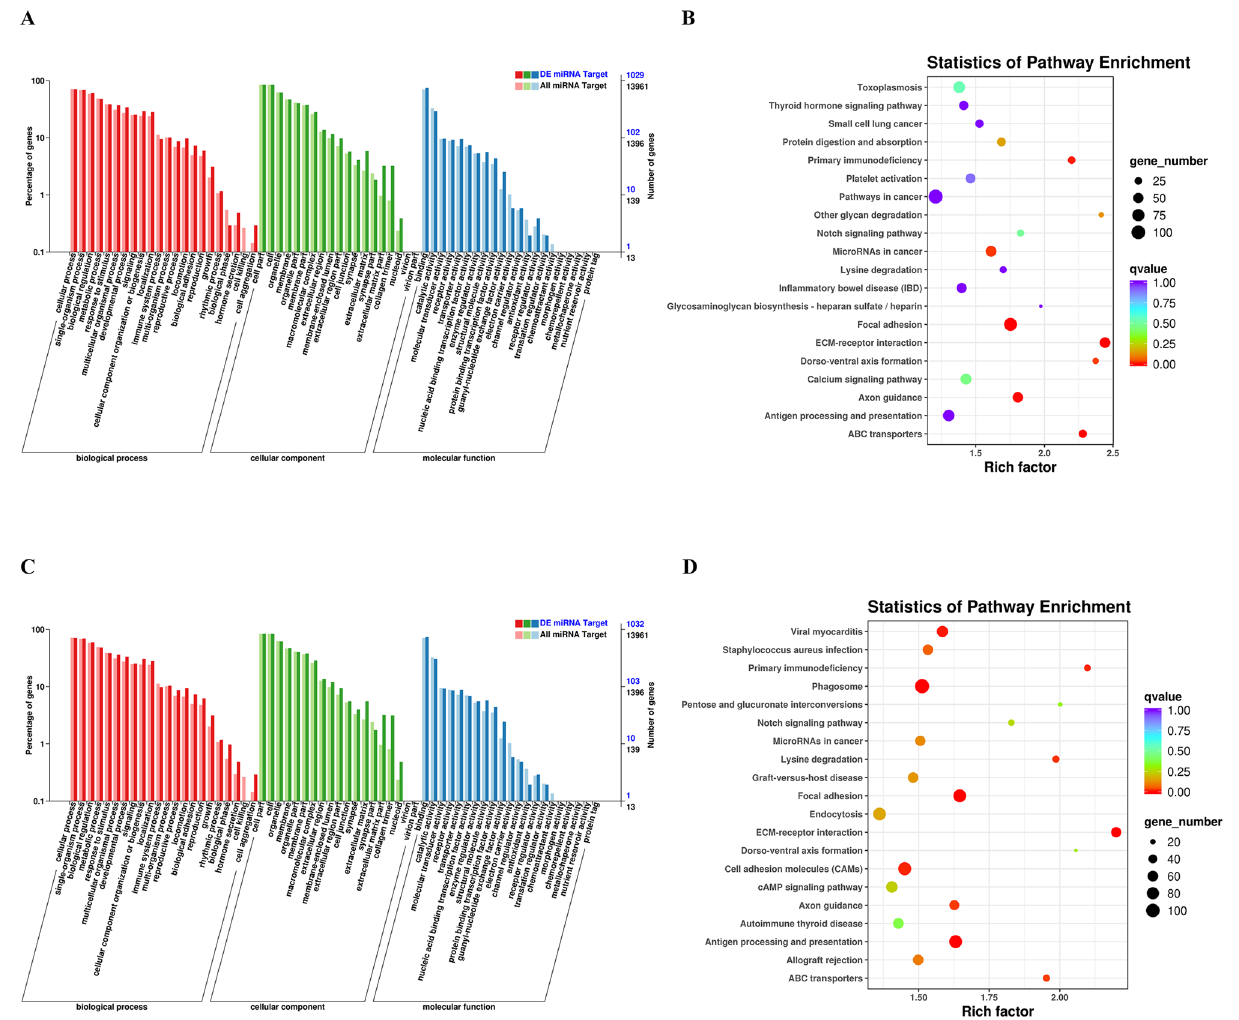
Figure 5. Major categories of GO terms and top 20 significantly enriched KEGG pathways regulated by candidate target genes of differentially expressed miRNAs. ( A ) Twenty most enriched GO terms in biological process, cellular component and molecular function for DE-miRNAs from HDPs vs HCs are listed. ( B ) KEGG pathways enriched for DE-miRNAs from HDPs vs HCs. Different color and diameter of the pathway dots represent significance level and gene number respectively. ( C ) Twenty most enriched GO terms in biological process, cellular component and molecular function for DE-miRNAs from HDPs vs HCs are listed. ( D ) KEGG pathways enriched for DE-miRNAs from MDPs vs HCs. Different color and diameter of the pathway dots represent significance level and gene number respectively. GO Gene Ontology, KEGG Kyoto Encyclopedia of Genes and Genomes, DE differentially expressed, MDPs Exosomes obtained from methamphetamine- dependent patients, HDPs Exosomes obtained from heroin-dependent patients, HCs Exosomes obtained from healthy